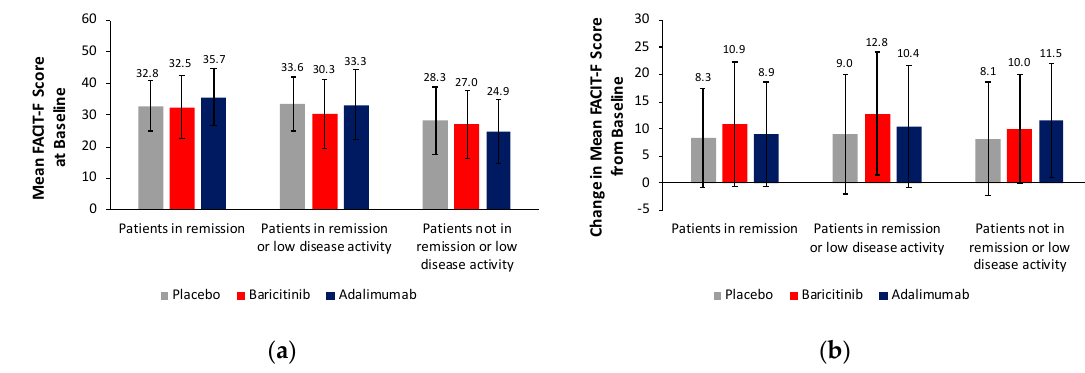
Figure 4. FACIT-F scores in patients from RA-BEAM by remission status ( a ) at baseline and ( b ) change at week 24. Error bars indicate standard deviation. FACIT-F scores at baseline and change in FACIT-F scores based on numbers of patients from RA-BEAM in remission (DAS28-ESR < 2.6): PBO + MTX n = 24, BARI + MTX n = 87, ADA + MTX n = 57; in remission or low disease activity (DAS28-ESR ≥ 2.6 and ≤ 3.2): PBO + MTX n = 46, BARI + MTX n = 154, ADA + MTX n = 110; and not in remission or low disease